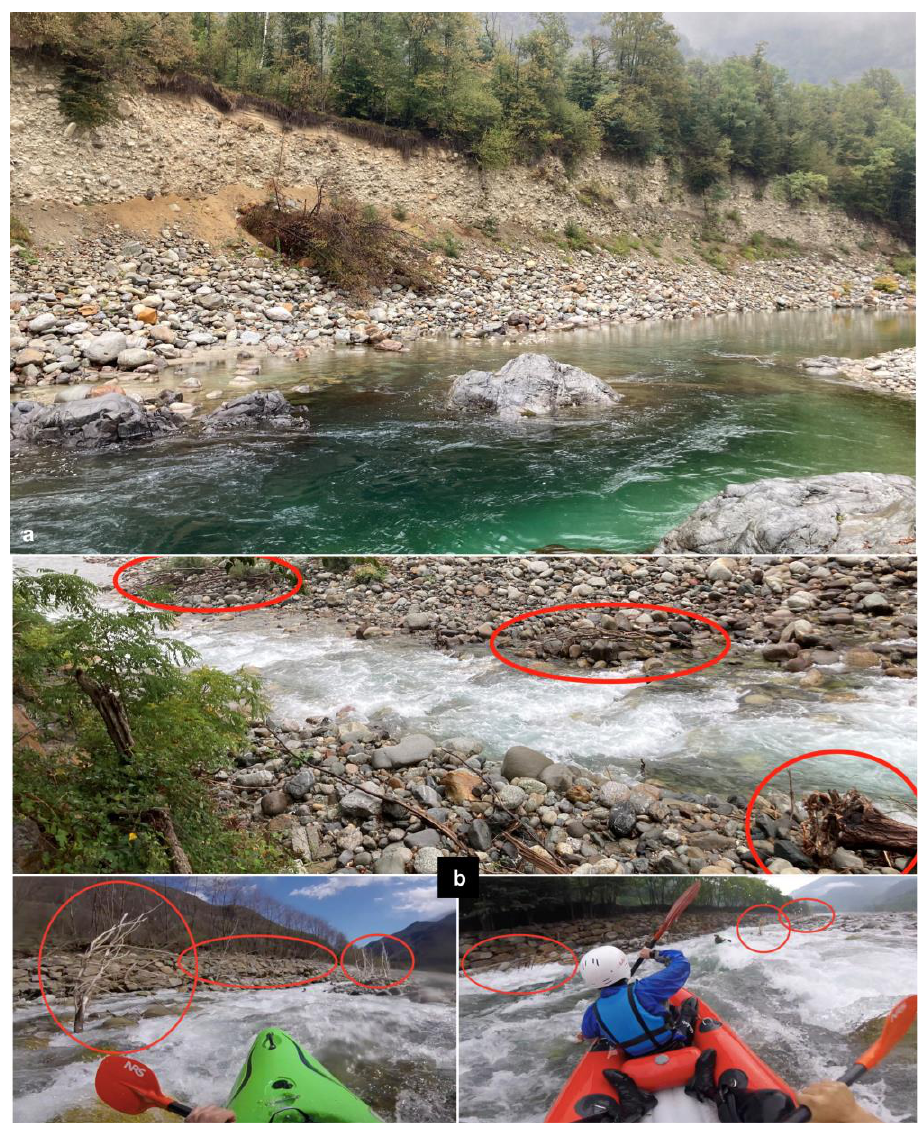
Figure 13. Examples of rocky and woody debris deposited along the river during the 2020 event and of human intervention within the riverbed along Classico del Sesia (CS) and Gole del Sesia (GS). ( a ) CS-M-AI, erosion of the riverbank along the Trancia rapid, IV WW degree; ( b ) CS-M-BG, abundant woody debris in the Impalatore rapid, IV WW degree. See location in Figure 8. Red ellipses indicate wood debris and broken trunks in the riverbed. For abbreviations, please see Section 3.1.